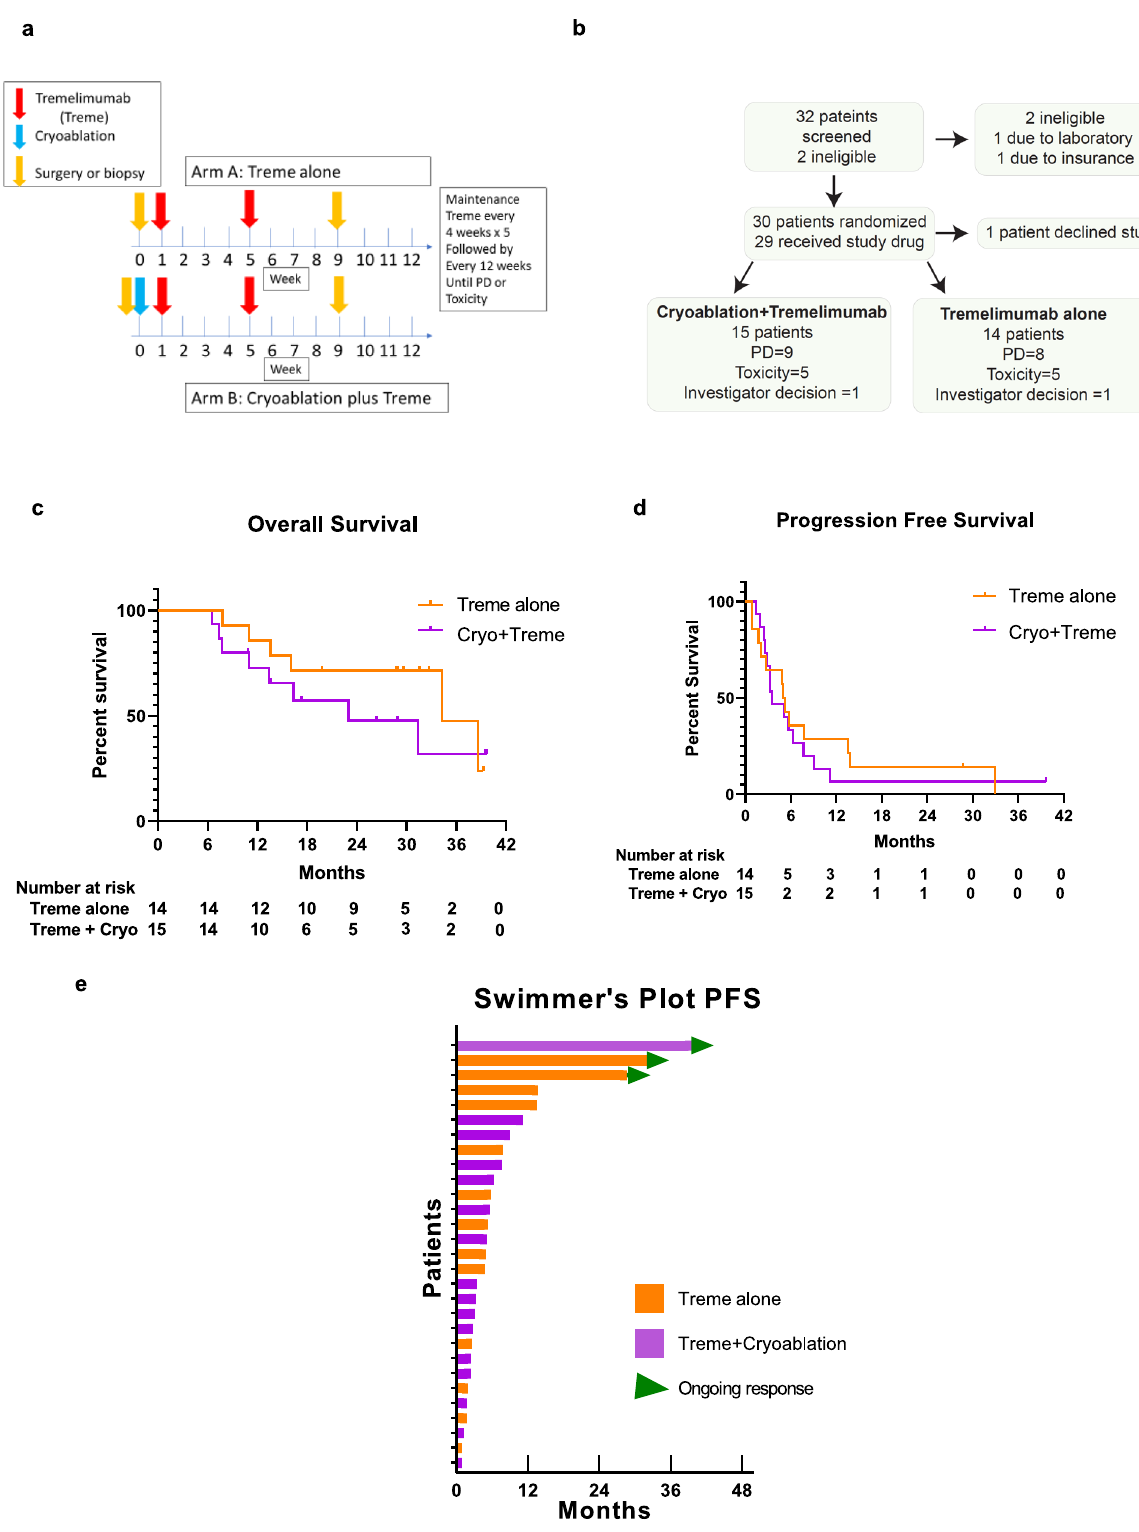
Fig. 1 Study design and outcomes. a Clinical trial schema. b Consort diagram showing patients accrued in the study. c and d Kaplan – Meier curves showing estimates of c overall survival and d progression-free survival, orange lines denote Treme alone arm and purple line denotes Cryo + Treme arm ( e ) Swimmer ’ s Plot with PFS based on treatment arm. Orange lines denote patients in the Treme alone arm, purple lines denote patients in the Cryo + Treme arm and green triangles show patients with an ongoing response. Treme tremelimumab monotherapy, Cryo + Treme Cryoablation + Tremelimumab combination therapy, PD progressive disease, PFS progression-free